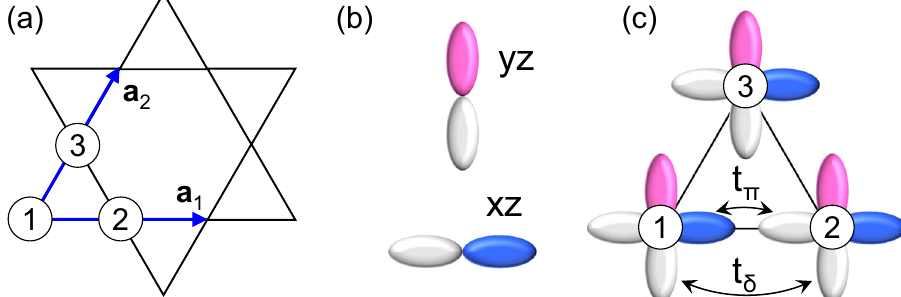
Fig. 1 Schematics of our theoretical model. a Kagome lattice with three sublattices, labeled 1, 2, and 3. The two arrows are lattice translation vectors a 1,2 . b Local orbitals a = yz and b = xz . Colored ellipsoids indicate regions of electron wave functions, where the sign is positive. c Nearest-neighbor hopping integrals. yz ( xz ) orbitals between site 1 and site 2 are hybridized via diagonal hopping t δ ( π ) , i.e., δ ( π ) bonding. Other hopping integrals between site 2 and site 3 and between site 1 and site 3 are obtained via the Slater rule 56 as shown in the Methods